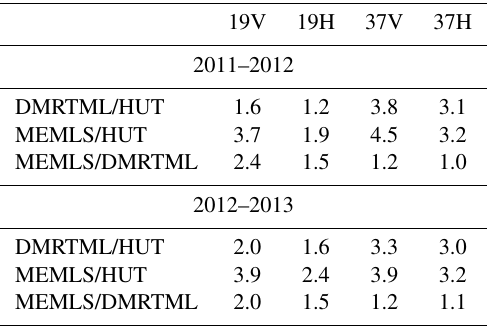
Table 5. Ratio of mean brightness temperature ranges simulated by two microwave emission models. The mean and max ratio between pairs of models is given in